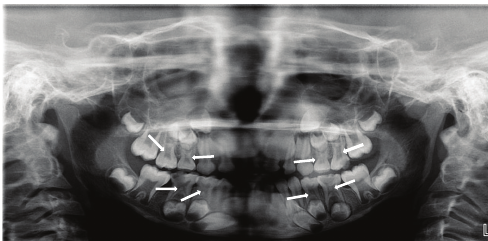
Figure 3: OPG revealing pulp stones in all primary molars (Case 2).